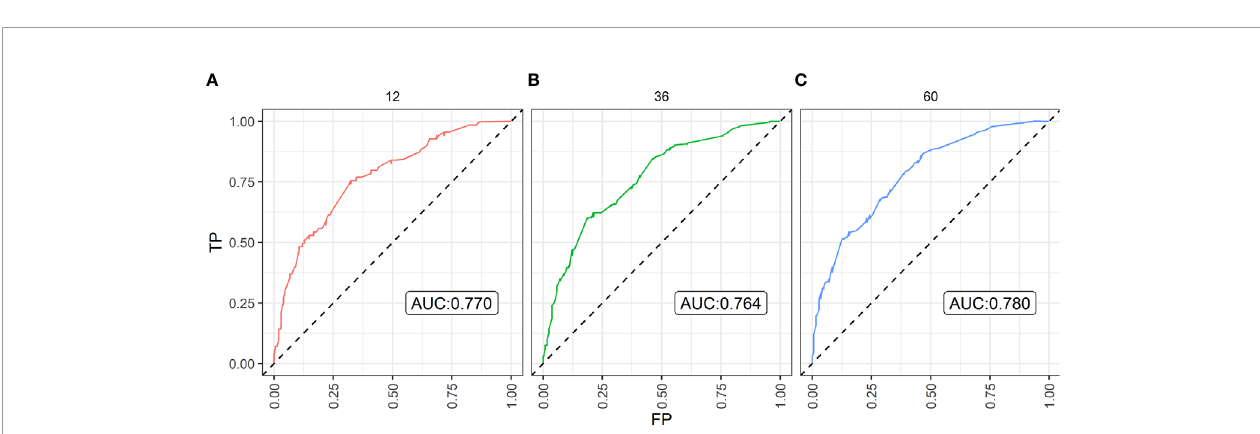
FIGURE 4 | The Area Under Curve (AUC) of the prediction nomogram on (A) 1-year, (B) 3-year, and (C) 5-year overall survival. TP, true positive; FP, false